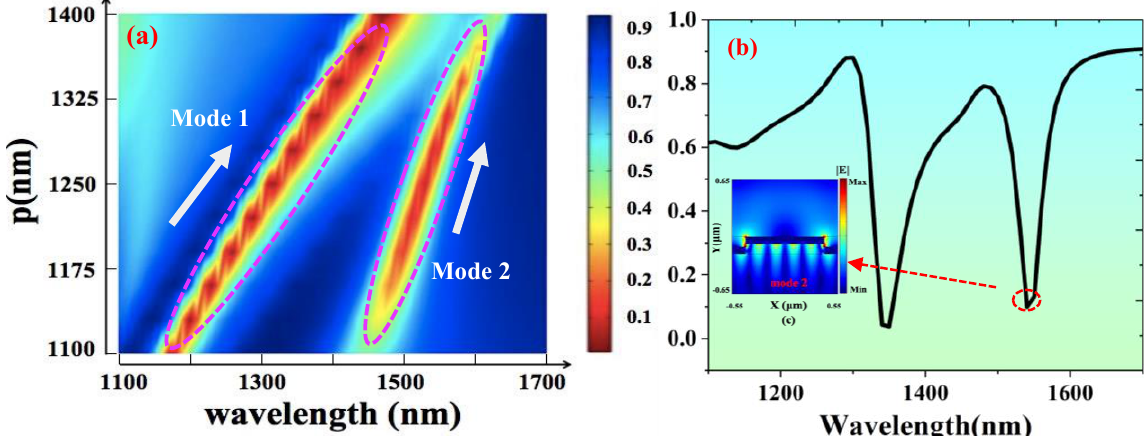
Figure 5. ( a ) A two-dimensional cloud group of the device refractive index obtained by scanning cycle width p (1100 nm – 1400 nm) when h1 = 120 nm, h2 = 80 nm, and w = 952 nm. ( b ) Simulated reflection spectra at h1 = 120 nm, h2 = 80 nm, p = 1280 nm, and w = 952 nm. Inset: the normalized electric field distribution of the corresponding Mode